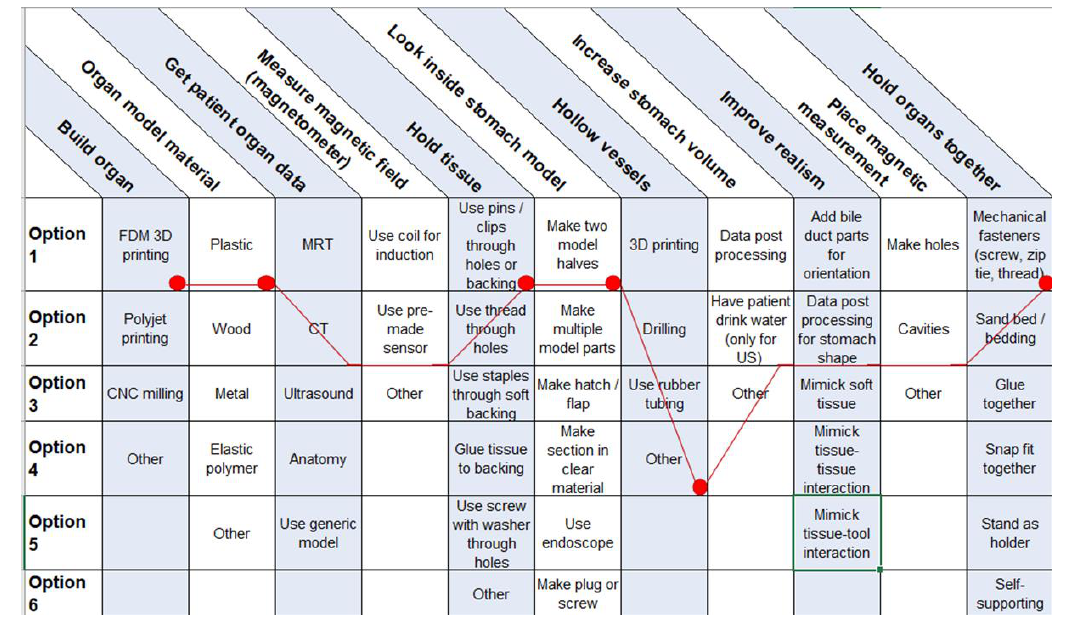
Figure 8. Morphologic box for 3D organ replicas with special regard to endoscopic tumor therapy with MNPs. Red dots represent our choices.